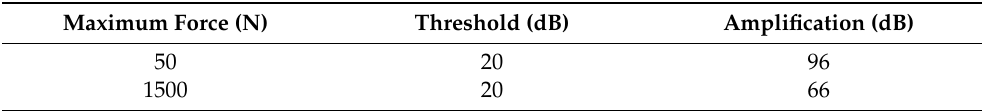
Table 3. AE detection